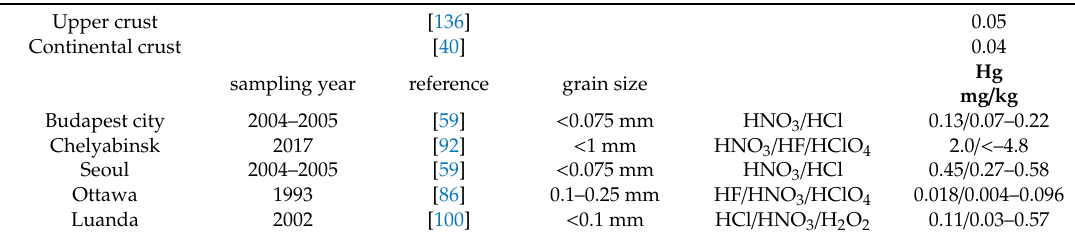
Table A30. Mercury in road dust.